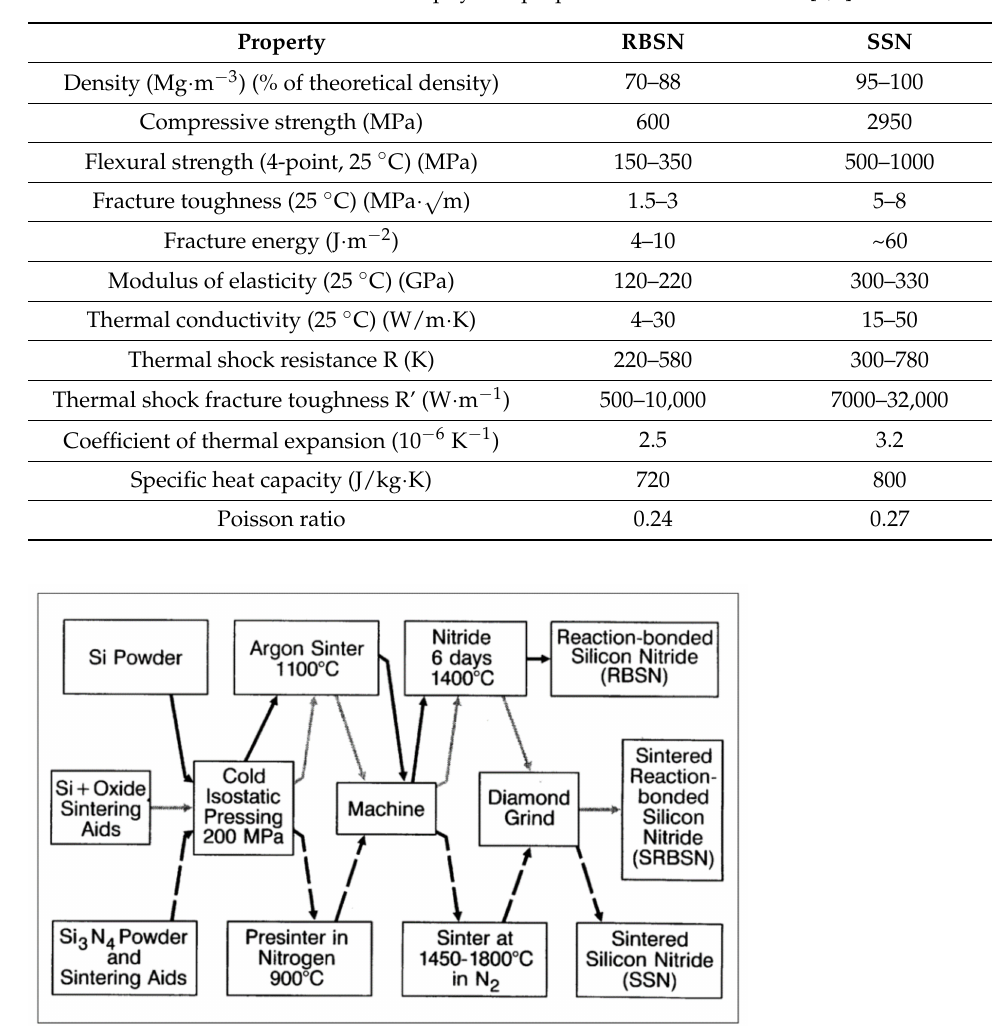
Table 1. Selected mechanical and thermophysical properties of RBSN and SSN [7,8].